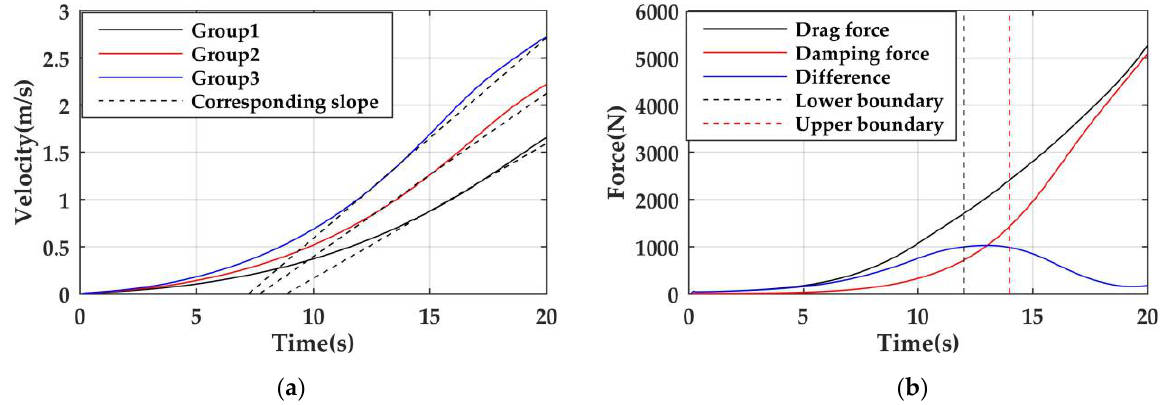
Figure 3. ( a ) The actual velocity development; ( b ) the difference force generated by the added mass in group 3. Table 3. Summary of added mass calculation.